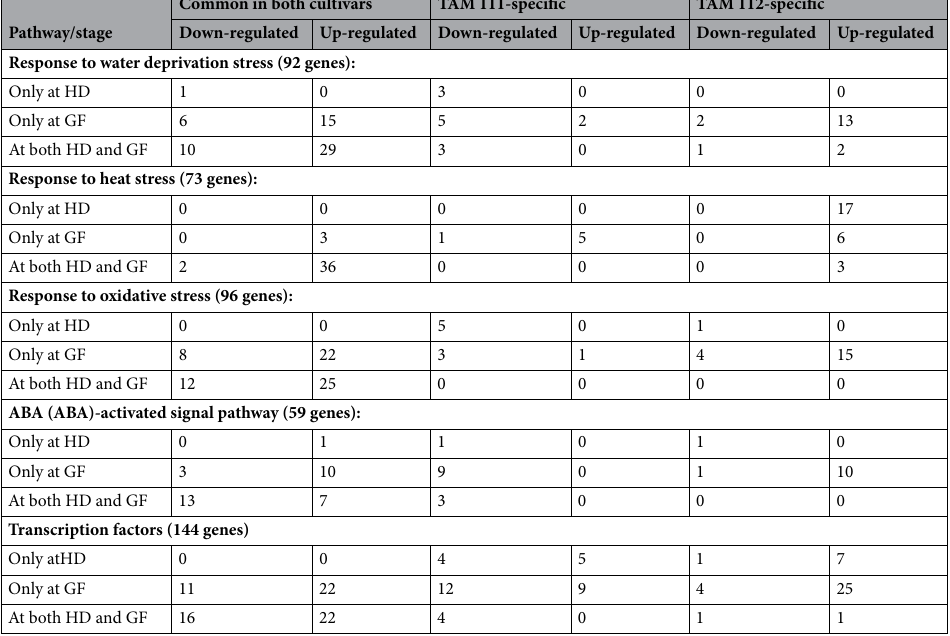
Table 4. Genes related to response to water deprivation, heat and oxidative stresses, ABA-signaling and transcription factors in TAM 111 and TAM 112 revealed by gene expression comparison under dry and wet conditions at heading (HD) and grain filling (GF)